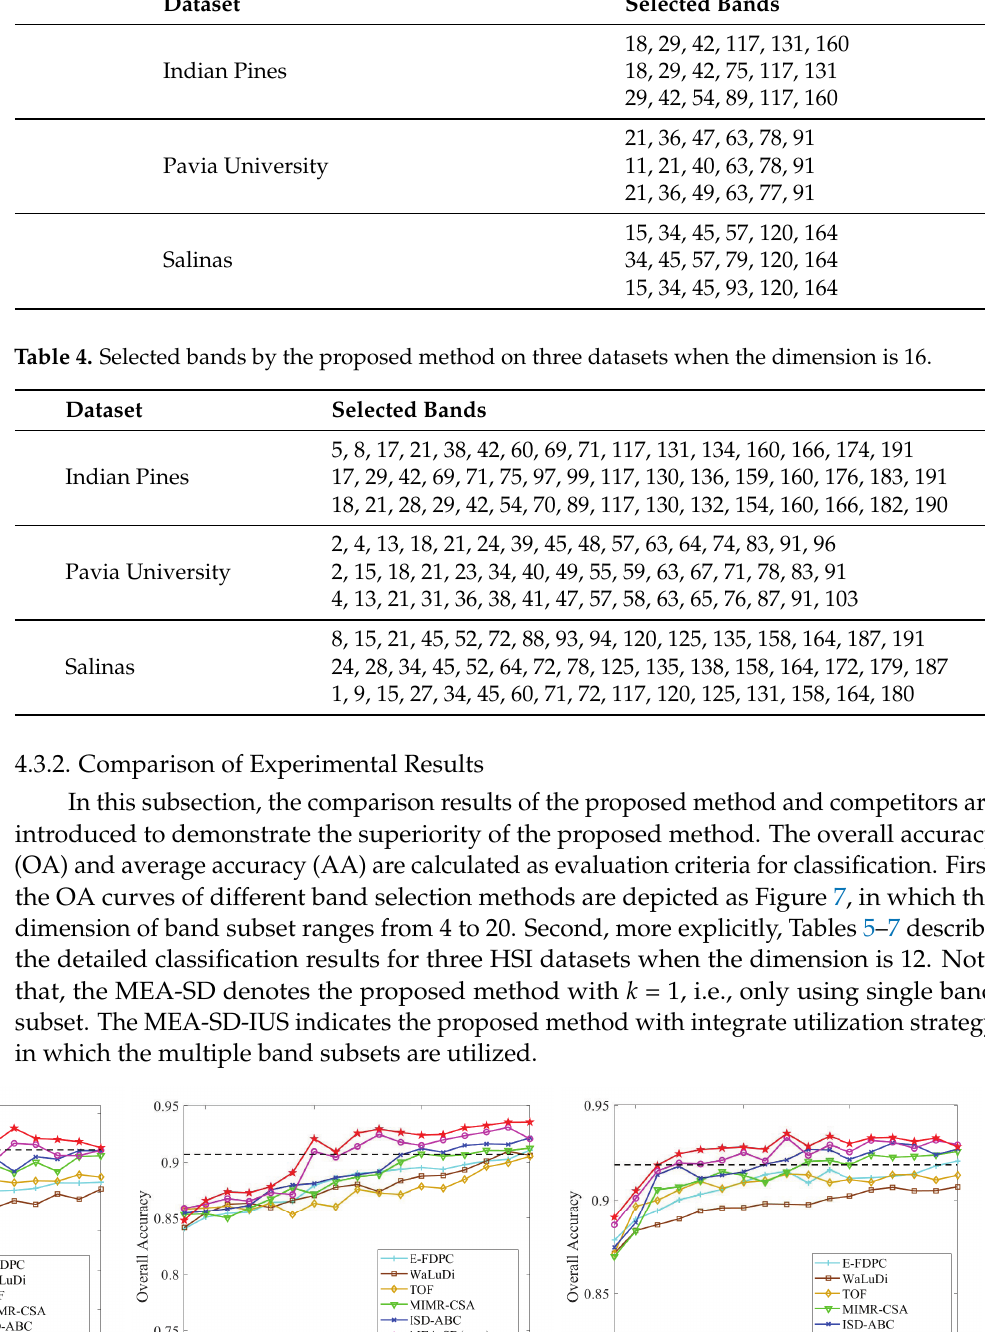
Table 3. Selected bands by the proposed method on three datasets when the dimension is 6. Dataset